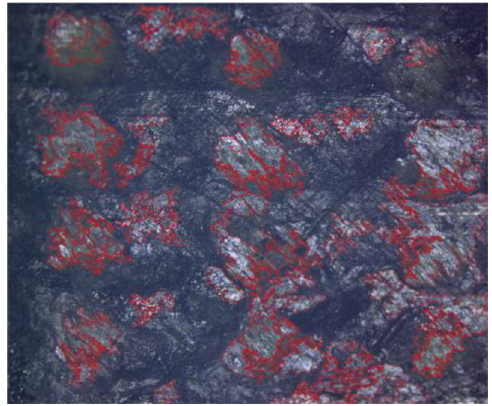
Fig. 8. Micrograph of the liner after binarization.